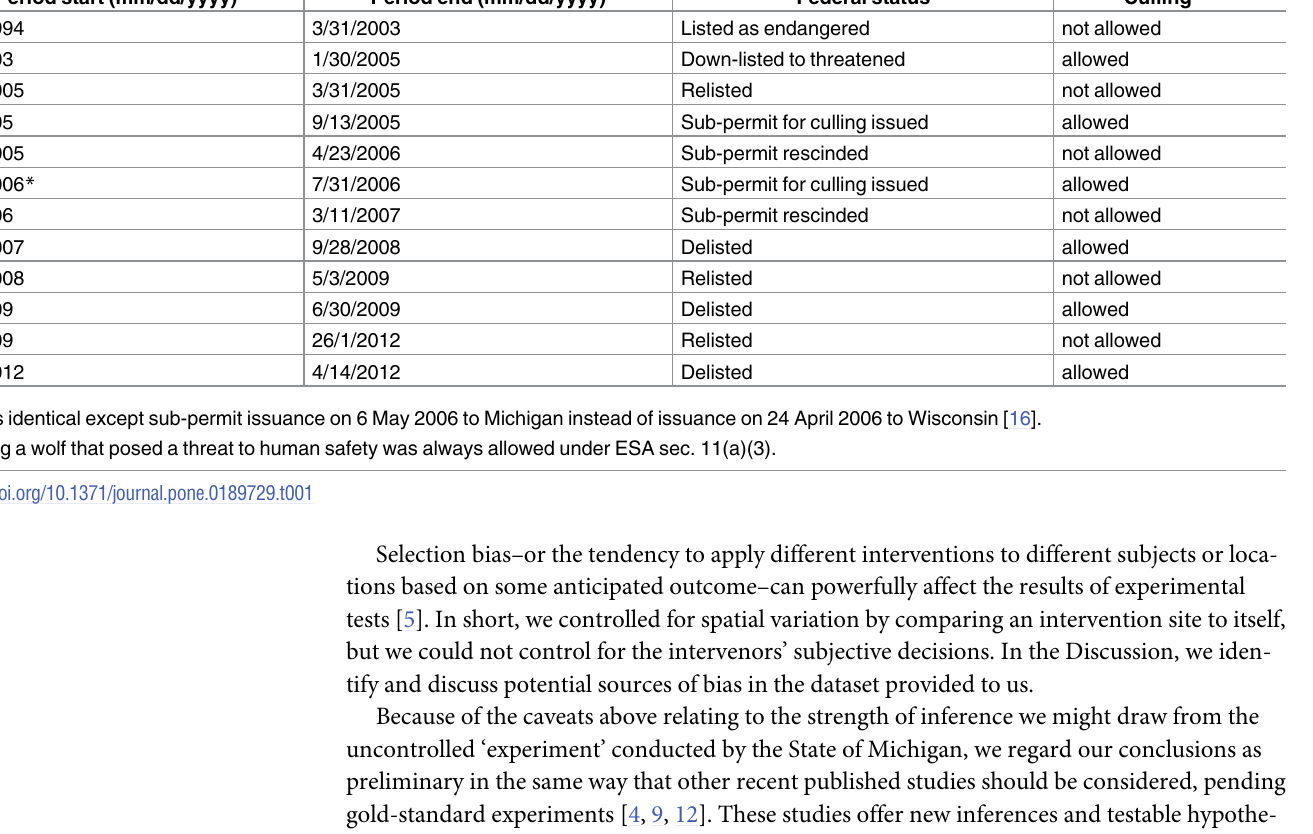
Table 1. Periods for wolf-killing policy signals in WI and MI, derived from Refsnider [16], ESA sec. 4 10(a)(1)(A) and Humane Society of the U.S. et al. v. Jewell (U.S. District Court, D.C., 5 1:13-cv-00186-BAHDocument 52, 2014). Period start